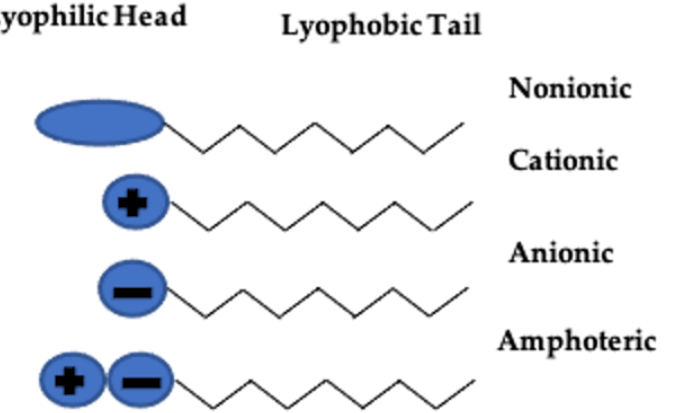
Figure 1. Basic molecular structure of surfactants. These molecules have dual affinities in aqueous environments, allowing them to self-assemble into different structures at the nano- and